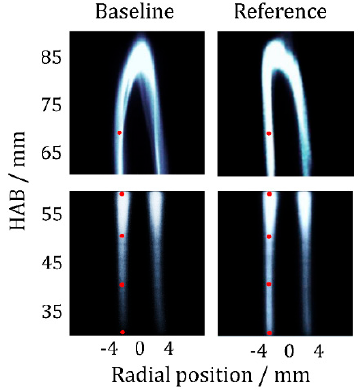
Figure 6. Mean LII images, average of 1000 single-shots.